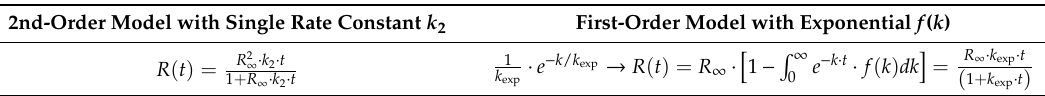
Table 2. Example of algebraical equivalence for the second-order model with single rate constant k 2 and a first order model with Exponential f ( k